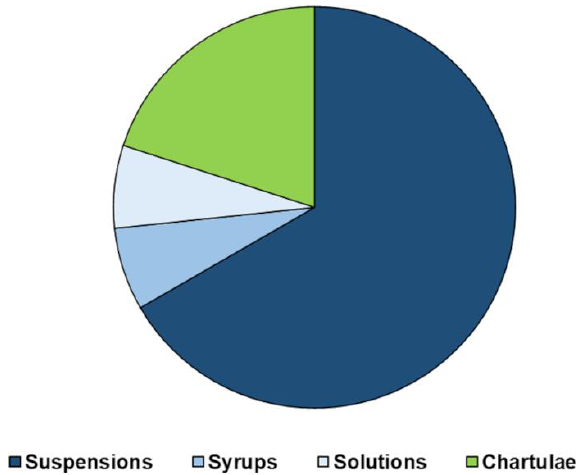
Figure 7. Pediatric preparations developed and dispensed by the G. Gaslini Hospital Pharmacy.